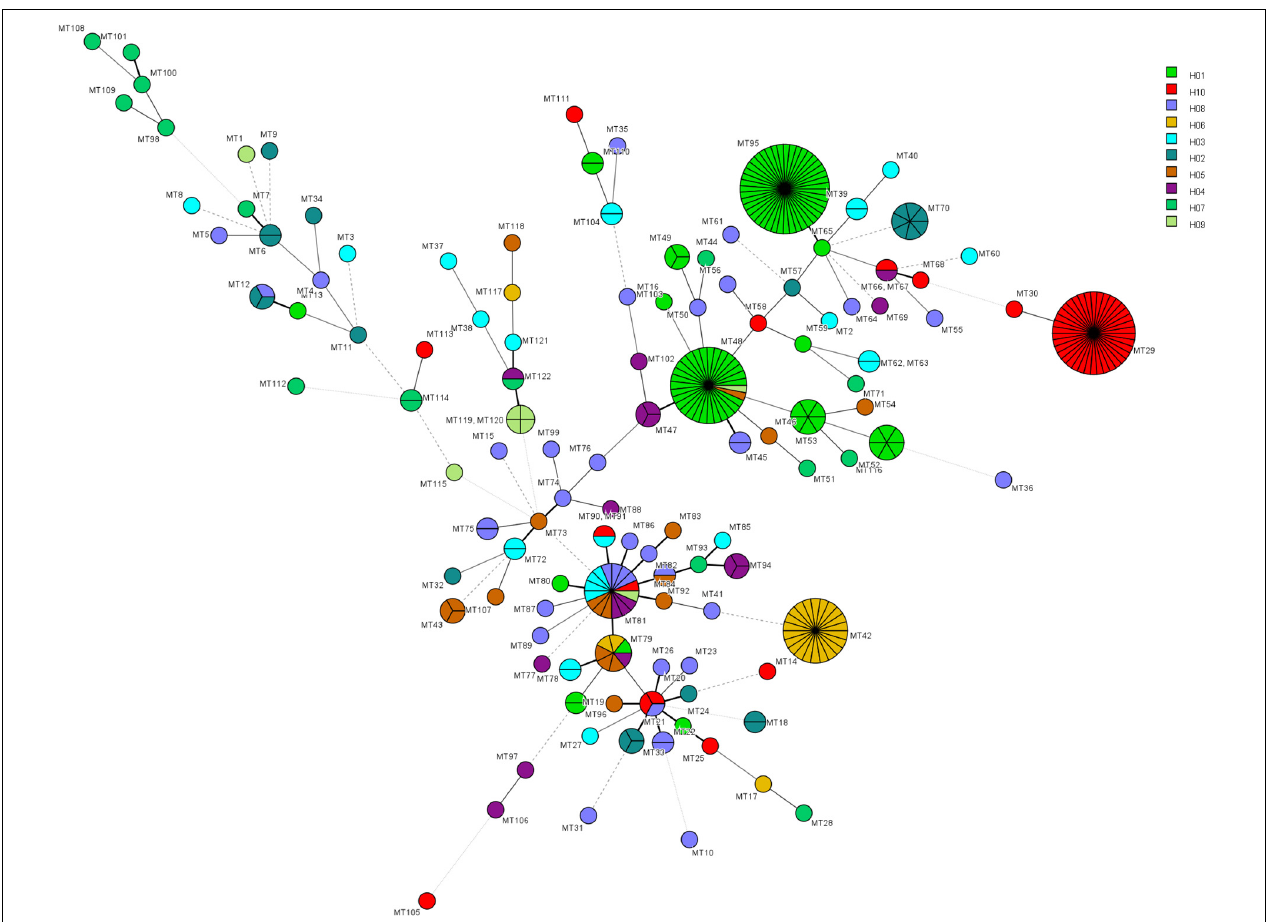
FIGURE 2 | Minimum spanning tree showing the relationship of 122 MT types among 319 isolates distributed in ten hospitals. Each circle represents a unique genotype. The size of the circle corresponds to the number of isolates of the specific genotype. Different colors represent different hospitals. Fluconazole resistant isolates were distributed in genotypes MT15 (H08, n = 1), MT47 (H04, n = 3), MT48 (H09, n = 1), MT50 (H08, n = 1), MT70 (H02, n = 7), MT75 (H08, n = 2), and MT114 (H07, n = 1). 5-flucytosine NWT strains were distributed in genotypes MT45 (H08, n = 2), MT48 (H01, n = 29), MT52 (H01, n = 1), MT88 (H04, n = 1), MT96 (H01, n = 2), MT97 (H04, n = 1), MT106 (H04, n =